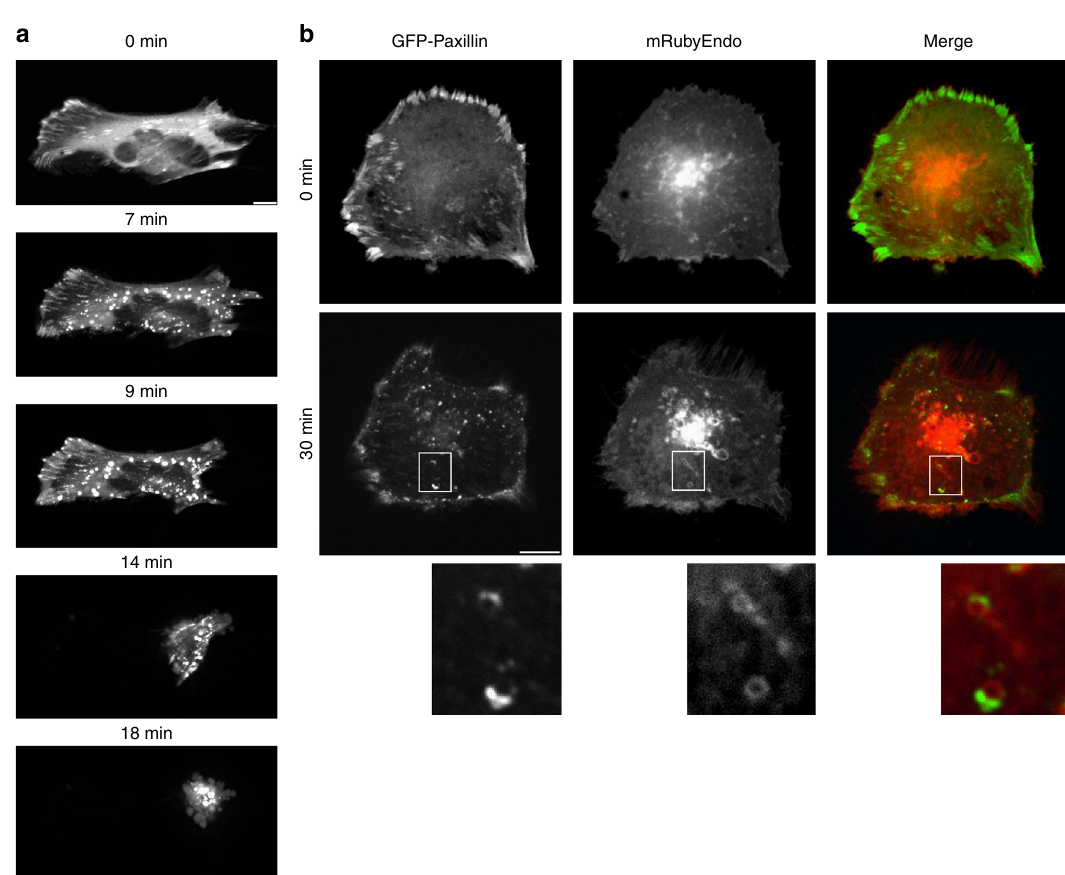
Fig. 4 Paxillin translocates from focal adhesions to early endosomes. a GT-induced cell detachment was studied by confocal video time-lapse microscopy. In response to 1 µ M GT, GFP-paxillin stably transfected into BEAS-2B cells translocates from focal adhesions at the plasma membrane (0 min) to vesicles (7 min), which move into the cell (7 – 18 min) (also see Supplementary Movie 1). This is followed by cell rounding and detachment (14 – 18 min). b Co-transfection of BEAS-2B cells with GFP-paxillin and mRuby-Endo-14 to visualise endosomes. Paxillin partially localised at endosomal membranes (see insets at higher digital magni fi cation). Scale bar = 10 µ